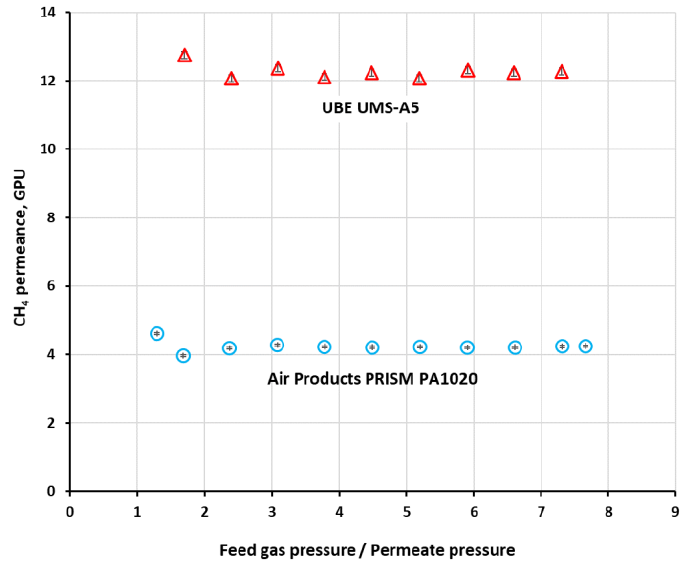
Figure 2. Gaseous streams in a membrane module for plug flow on the feed side and unhindered flow on the permeate side.